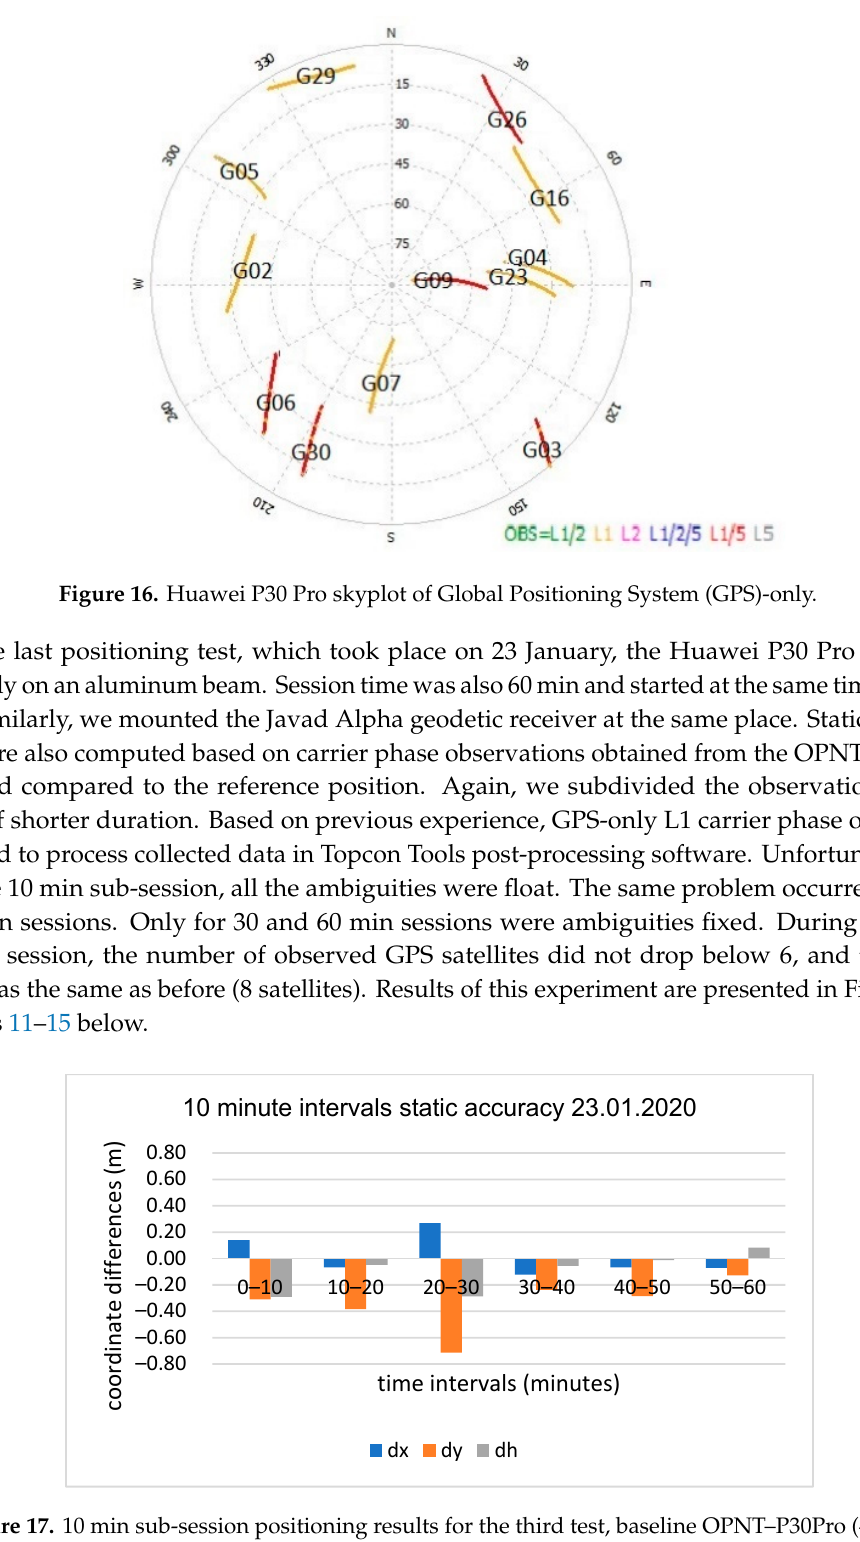
Table 10. 60 min session positioning results summary, baseline OPNT–P30Pro (4 km).